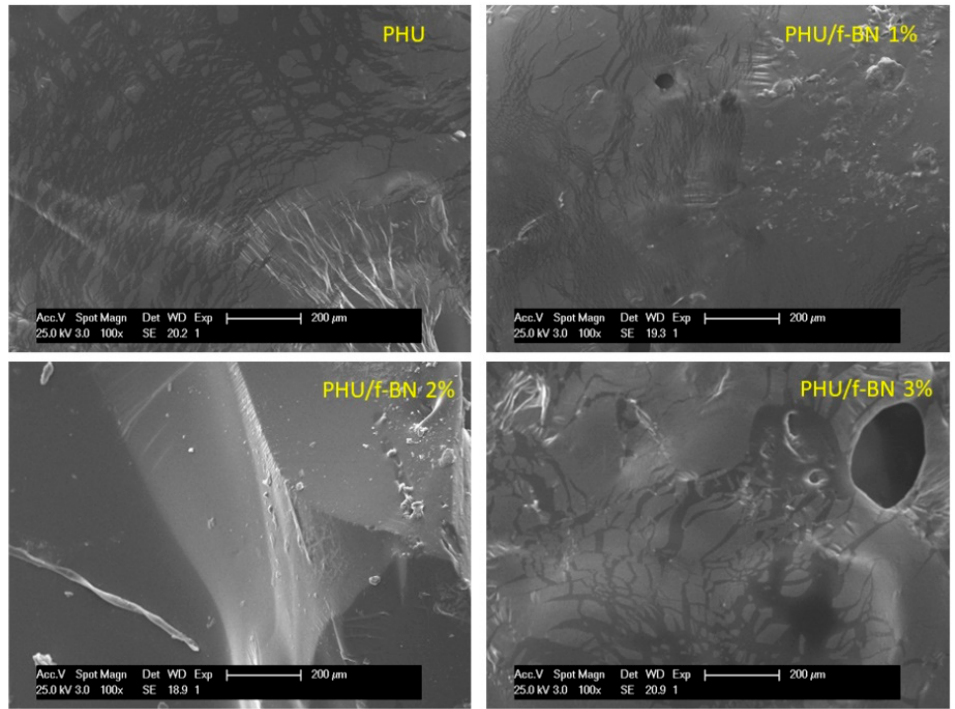
Figure 7 . SEM images of PHU polymer and PHU/f-BN composites . Figure 7. SEM images of PHU polymer and PHU/f-BN